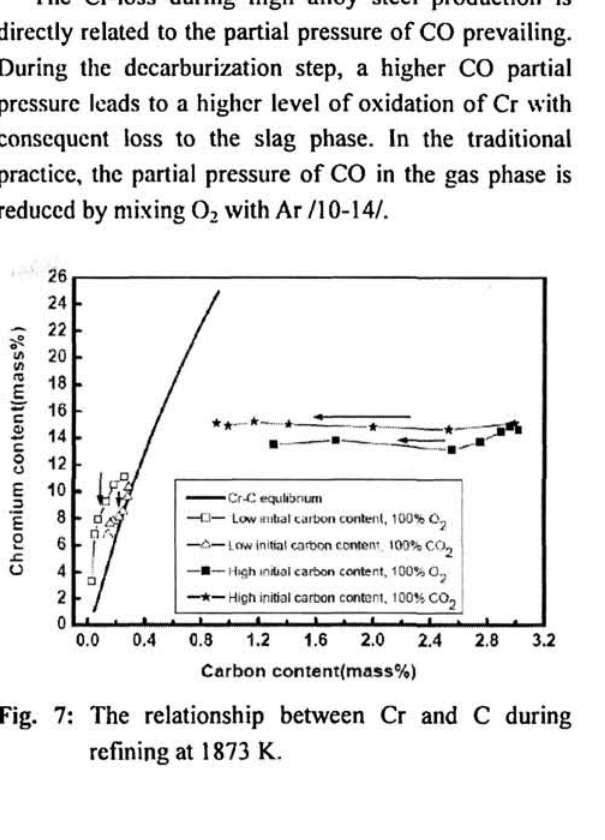
Fig. 7: The relationship between Cr and C during refining at 1873